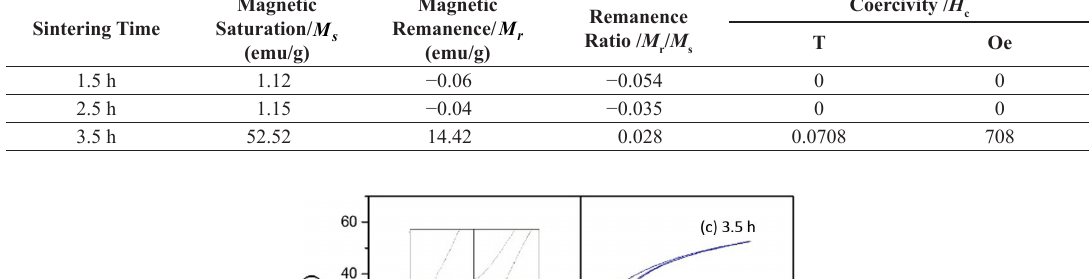
Table 2. Magnetic Properties of ZnFe Sintering Time